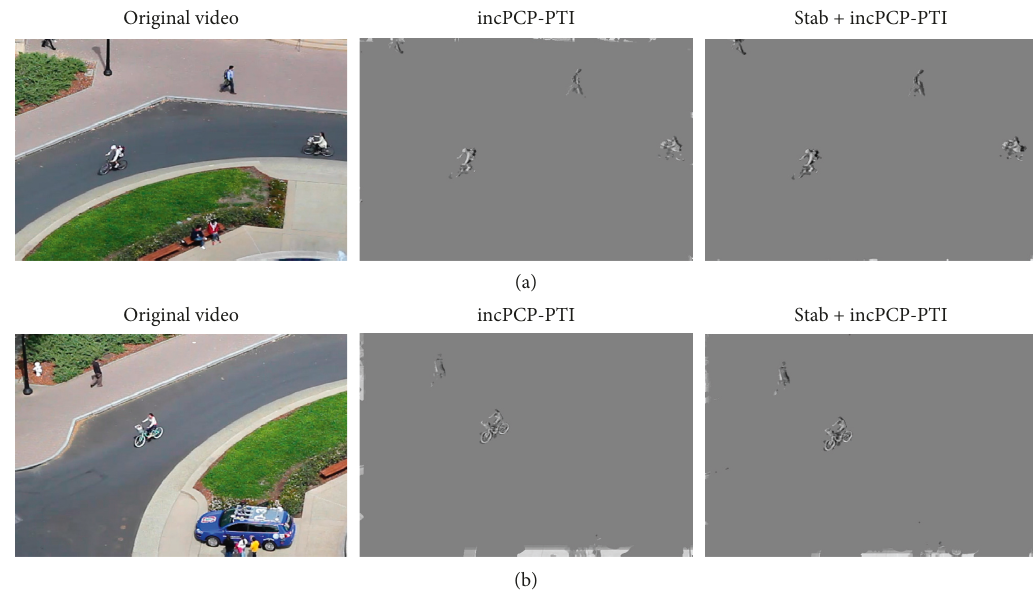
Figure 3: Representative frames of the video and the segmented sparse components for the SPJ dataset. Frames (a) 100 and (b) 355. This figure is a slightly modified version of Figure 3 in [28].